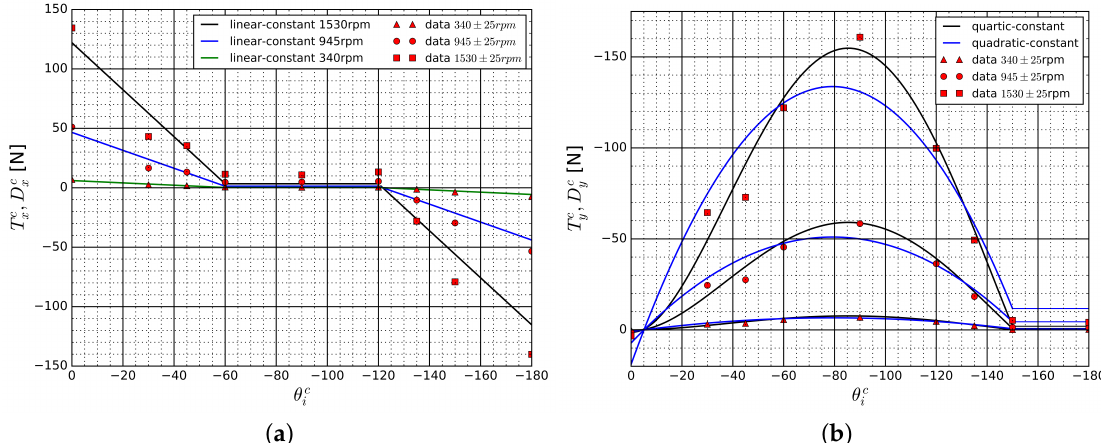
Figure 11. Alternative model fits: ( a ) piecewise linear model for T c x , and ( b ) constant thrust zone model for T c y